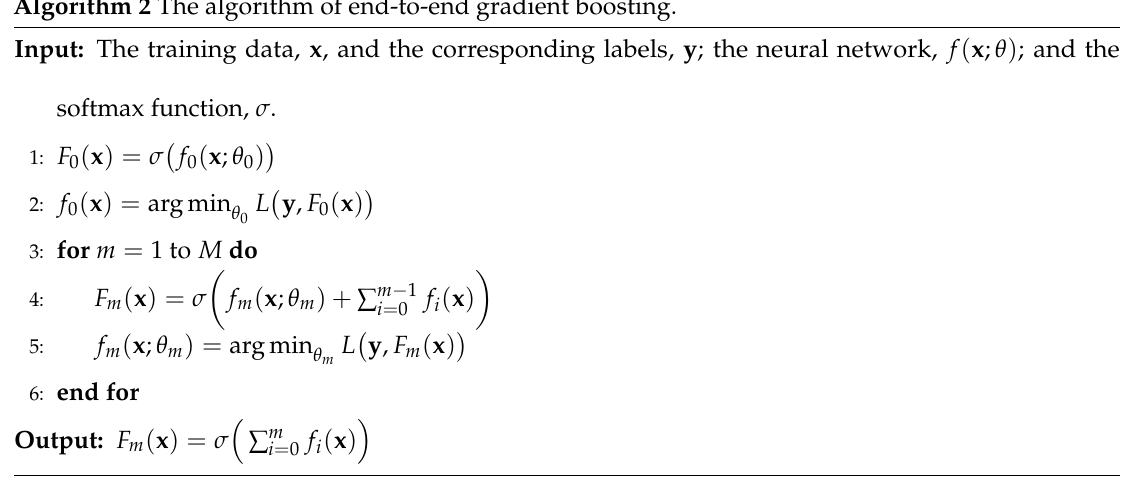
Algorithm 2 The algorithm of end-to-end gradient